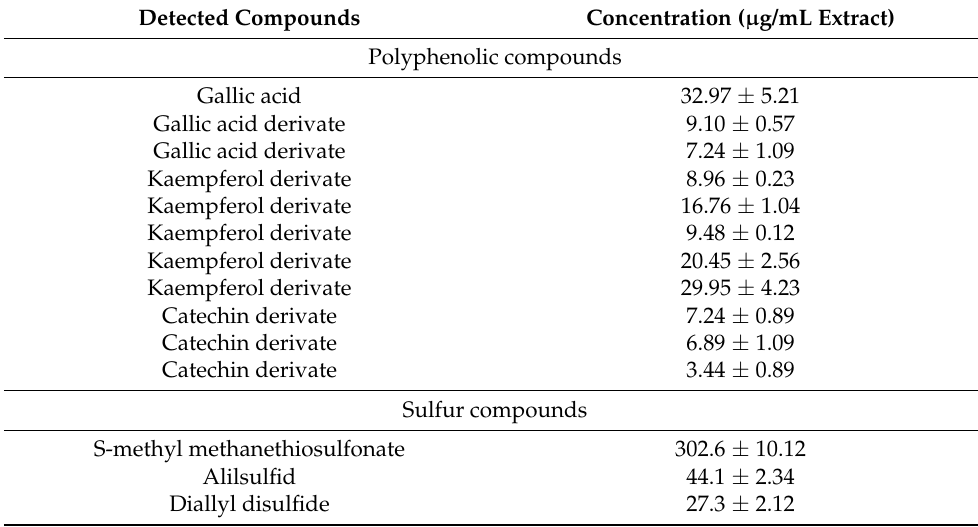
Table 1. Chemical composition of A. ursinum extract detected by